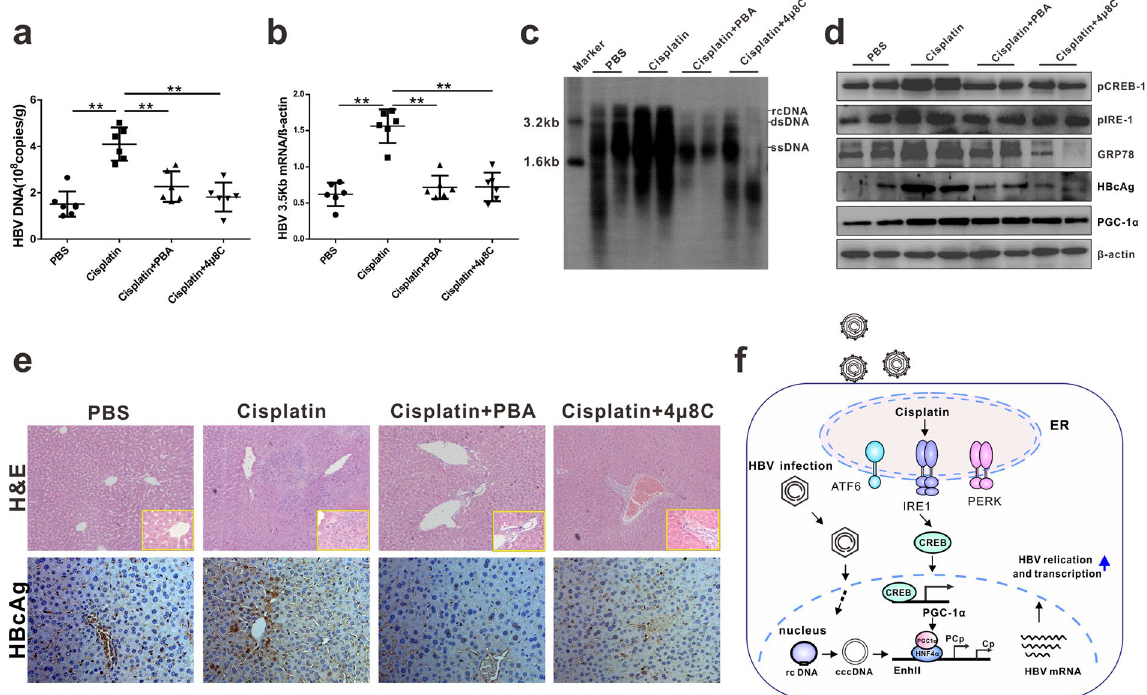
Figure 7. ER stress inhibitors alleviate cisplatin-induced HBV reactivation in HBV transgenic mouse model. HBV transgenic mice were randomly divided into four groups (n = 6 for each group). Animals received 100 mg/kg PBA or 10 mg/kg 4 μ 8C for 1 day, followed by treatment with PBA or 4 μ 8C combined with 6.0 mg/kg cisplatin daily for 5 days. On the sixth day, the mice were sacrificed and serum and tissue samples were collected. ( a to b ) HBV DNA and 3.5 kb mRNA in the liver were detected by real-time PCR. ( c ) HBV replication intermediates in the liver were detected by Southern blotting. ( d ) The expression of the indicated ER stress inducible proteins, HBcAg and PGC1 α were analyzed by western blot. The cropped blots are used in the figure and full length blots are presented in Supplementary Fig. S11. ( e ) Liver tissue sections were H&E stained or stained with anti-HBc antibodies (magnification, × 200). ( f ) A schematic model by which cisplatin induces PGC1 α through ER stress and strengthens HBV